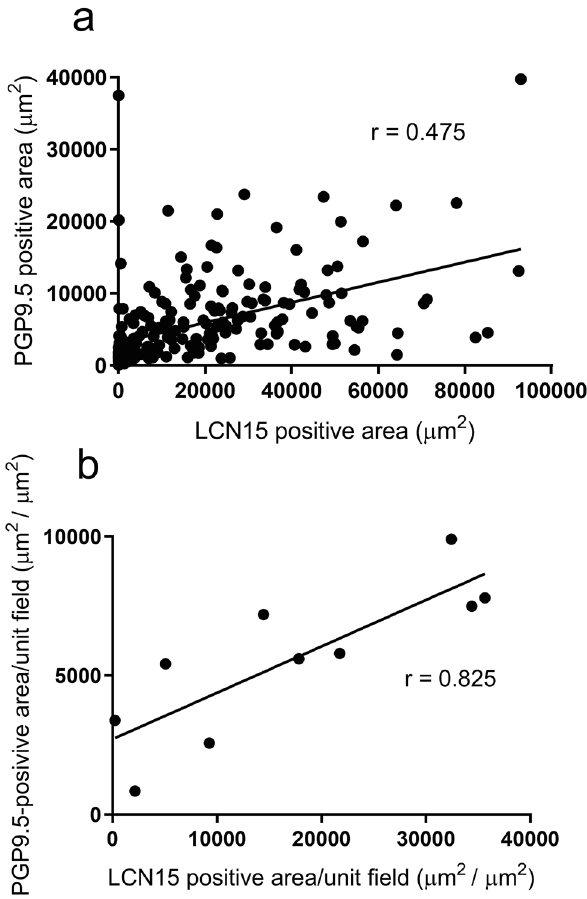
Figure 5. Distribution correlation of LCN15-immunoreactive and PGP9.5-immunoreactive areas in the olfactory cleft mucosa. ( a ): The total area of LCN15 immunoreactivity and that of PGP9.5 immunoreactivity in each rectangle field were significantly correlated (Spearman’s rank correlation, r = 0.475; P < 0.0001). ( b ): The total area of LCN15 immunoreactivity along the unit field of olfactory cleft mucosal lining in each participant was significantly correlated with that of PGP9.5 immunoreactivity (Spearman’s rank correlation, r = 0.825; P = 0.0033).